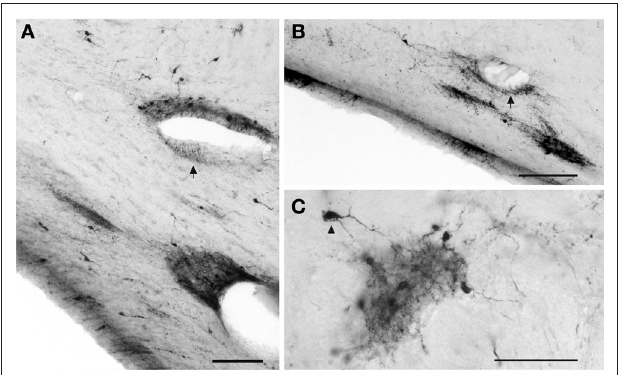
FIGURE 3 | CR+ neurons in the deep WM of the temporal lobe. (A,B) Clusters of small neurons are concentrated near blood vessels. The arrows point to fi bers running along the vascular wall. (C) Cluster in the deep WM. The dense local axonal plexus is mostly confi ned to the cluster, with few fi bers extending into the neighboring WM. The arrowhead points to an axon contacting a soma. Scale bar in (A) 50 µm, in (B) 100 µm, in (C) 50 µm.